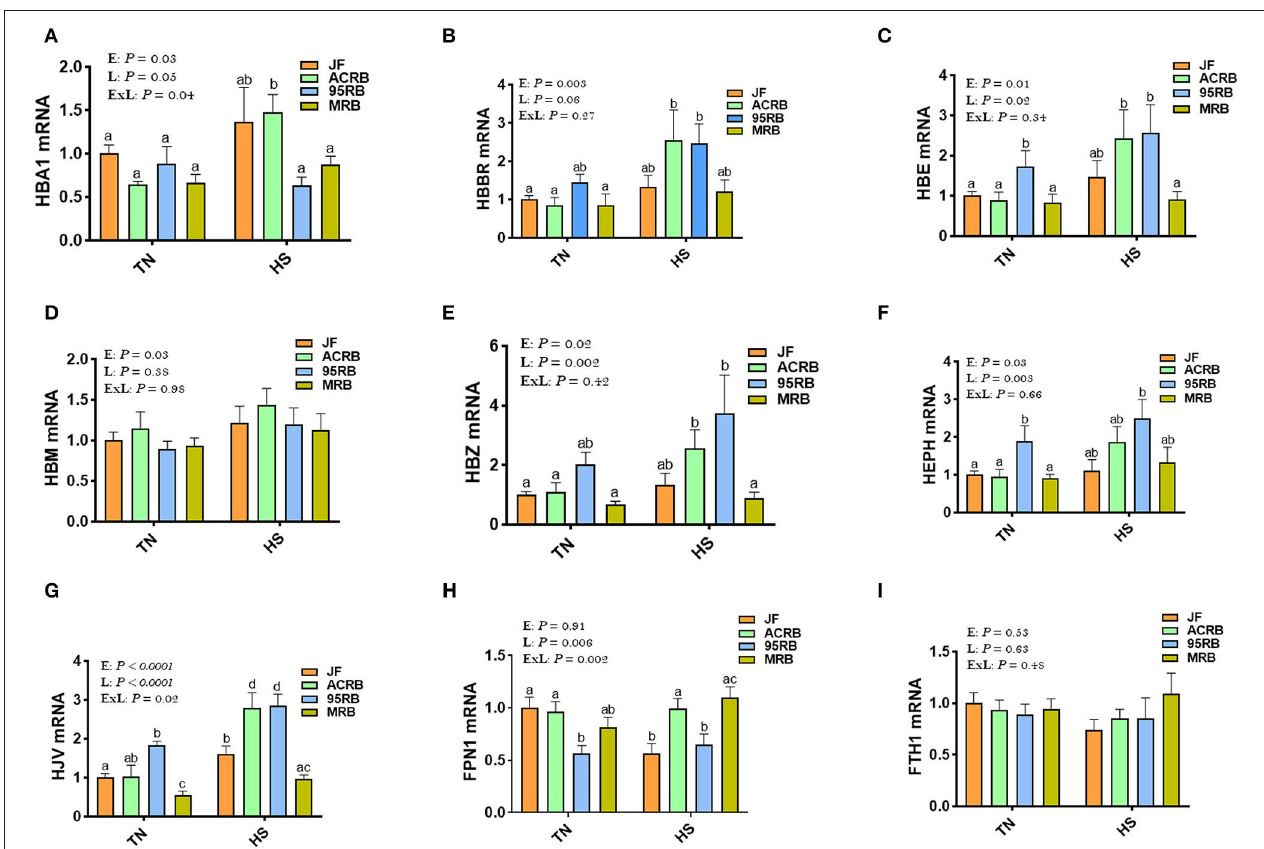
FIGURE 2 | Effect of HS on hypothalamic expression of oxygen homeostasis-associated genes in three modern broilers and their ancestor JF. RNA was extracted from hypothalamic tissues and analyzed by qPCR using 2 − 11 CT method. Data for gene expression of HBA1 (A) , HBBR (B) , HBE (C) , HBM (D) , HBZ (E) , HEPH (F) , HJV (G) , FPN1 (H) , and FTH1 (I) are mean ± SEM ( n = 6/group). Different letters indicate significant difference at P < 0.05. 95RAN, 1995 random bred; ACRB, Athens Canadian Random Bred; E, environment; ExL, interaction between E and L; FTH1, Ferritin Heavy Chain 1; FPN1, Ferroportin-1; HBA1, hemoglobin Subunit Alpha; HBBR, hemoglobin beta, subunit rho; HBE, hemoglobin E; HBM, hemoglobin Subunit Mu; HBZ, hemoglobin Subunit Zeta; HEPH, hephaestin; HJV, hemojuvelin; HS, heat stress (36 ◦ C); JF, jungle fowl; L, line; MRB, modern random bred; TN, thermoneutral (25 ◦